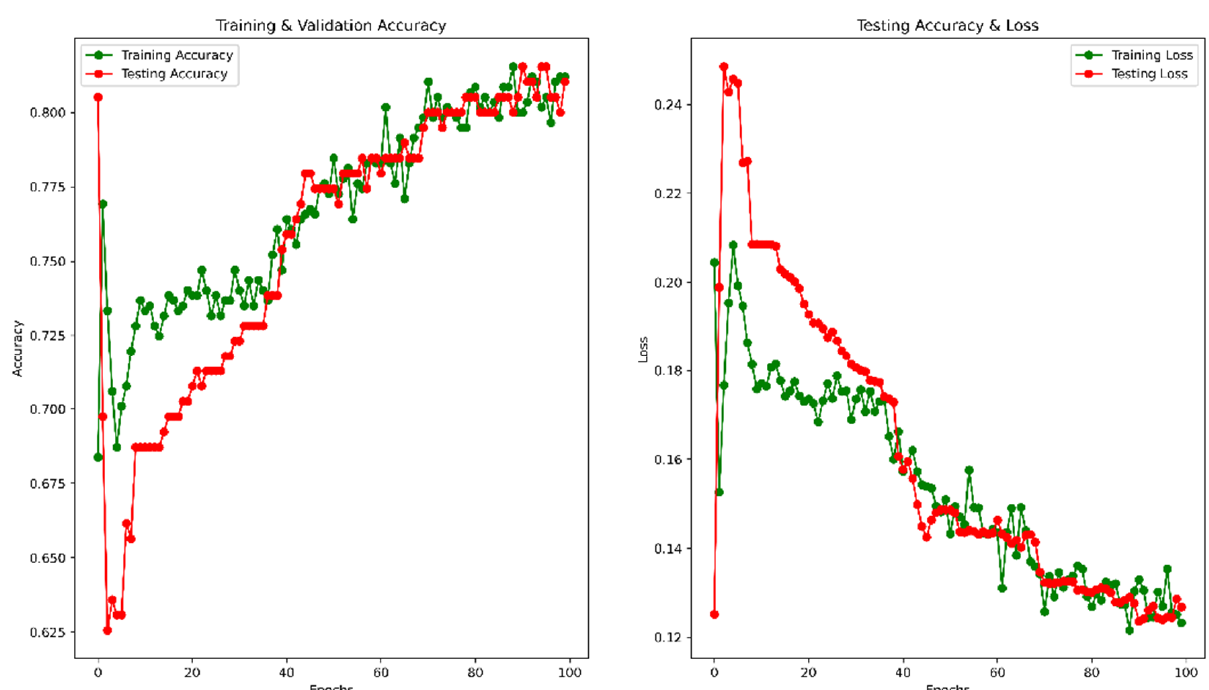
Figure 6. Accuracy and Loss vs. Epoch for masked image training.